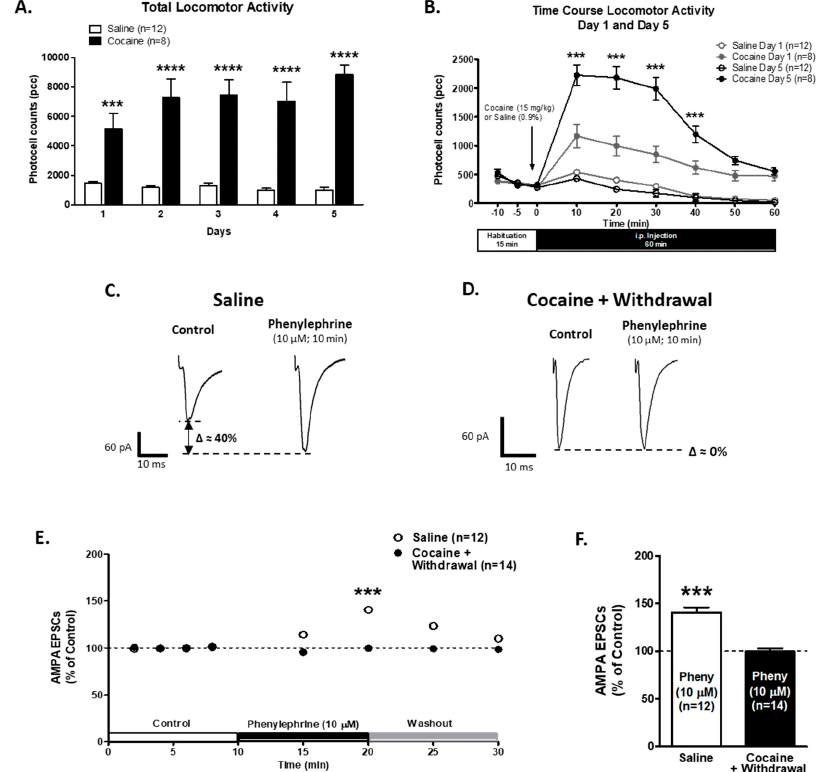
Figure 4. α 1-ARs-mediated effect on AMPA EPSCs is still absent in VTA DA neurons after a 7-day withdrawal period. ( A ) A bar graph showing the total locomotor activity recorded from saline- (0.9%, white bars; n = 12) and cocaine- (15 mg/kg i.p., black bars; n = 8) treated animals. Cocaine-injected animals showed a progressive increase in locomotor activity over 5 days when compared to saline-injected animals (Two-way repeated measures ANOVA, day factor F5,72 = 3.28; p < 0.05; treatment factor F1,72 = 75.42, p < 0.0001). On day 5, the total activity was significantly increased when compared to day 1 in cocaine-treated animals (Bonferroni post hoc test p < 0.0001). ( B ) The time course of locomotor activity on days 1 (grey) and 5 (black) of cocaine- (15 mg/kg, i.p.; n = 8) (filled) or saline- (unfilled; n = 12) treated animals. Cocaine sensitization was manifested as an increase in locomotor activity during the first 40 min after cocaine injection in comparison with day 1. The data (pcc/60 min; Mean ± SEM) were analyzed by Two-way repeated measures ANOVA (treatment factor F3,180 = 72.73; p < 0.0001; time factor F5,180 = 110.2; p < 0.0001), Bonferroni post hoc test ( p < 0.001). ( C , D ) Representative recordings from saline- and cocaine-treated animals after 7 days of withdrawal, respectively, illustrating that phenylephrine superfusion (10 μ M, 10 min) induces a significant increment in AMPA EPSCs amplitude only in VTA DA neurons from saline-treated animals. ( E ) The time course summary of the effects of phenylephrine bath application on AMPA EPSCs amplitude recorded from 12 VTA DA neurons from saline-treated animals and 14 VTA DA neurons from cocaine-treated animals at 8 min of control (2 min intervals), 5 and 10 min phenylephrine (10 μ M), and 5 and 10 min washout. A 10 min phenylephrine application increases the AMPA EPSCs amplitude only in neurons from saline-treated animals (Two-way repeated measures ANOVA, time factor F7,168 = 11.68, p < 0.0001; treatment factor F1,168 = 21.20, p < 0.001). A Bonferroni post hoc test demonstrated significant differences between saline and cocaine EPSCs recordings after 5 and 10 min of phenylephrine superfusion ( p < 0.001). ( F ) A bar graph showing that, in neurons from saline-treated animals ( n = 12 / 12), phenylephrine application resulted in a ~40% increase in AMPA EPSCs amplitude. No significant di ff erences were observed on VTA DA neurons from cocaine-treated animals after 10 min of phenylephrine application when compared to control EPSCs recordings (99.6 ± 3.3%, n = 14 / 8, One-way ANOVA, Newman-Keuls post-hoc, p < 0.001). *** p < 0.001, **** p < 0.0001. n = the number of cells recorded / number of